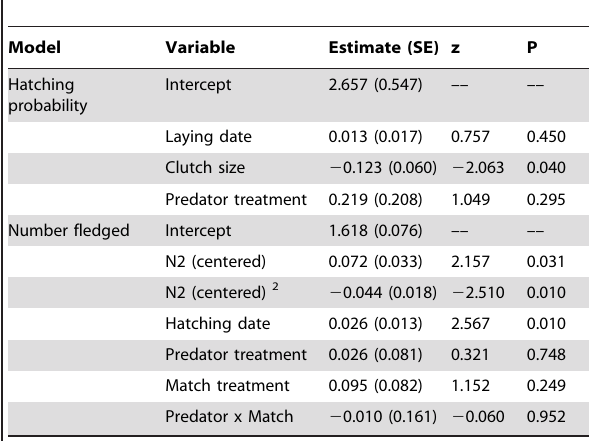
Table 1. Summaries for hatching and fledging probability GLMs.